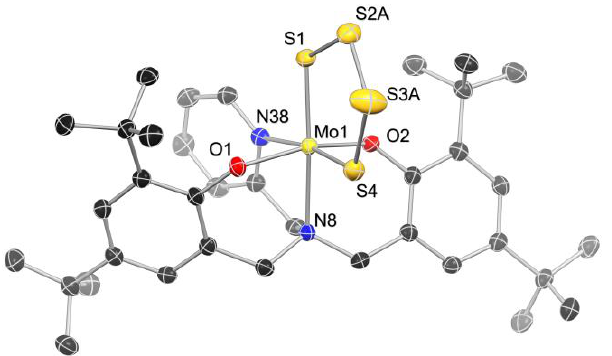
Figure 1. Molecular structure of 2 , with H-atoms and disorder of the S-atoms omitted. Displacement ellipsoids are drawn at the 50% probability level.